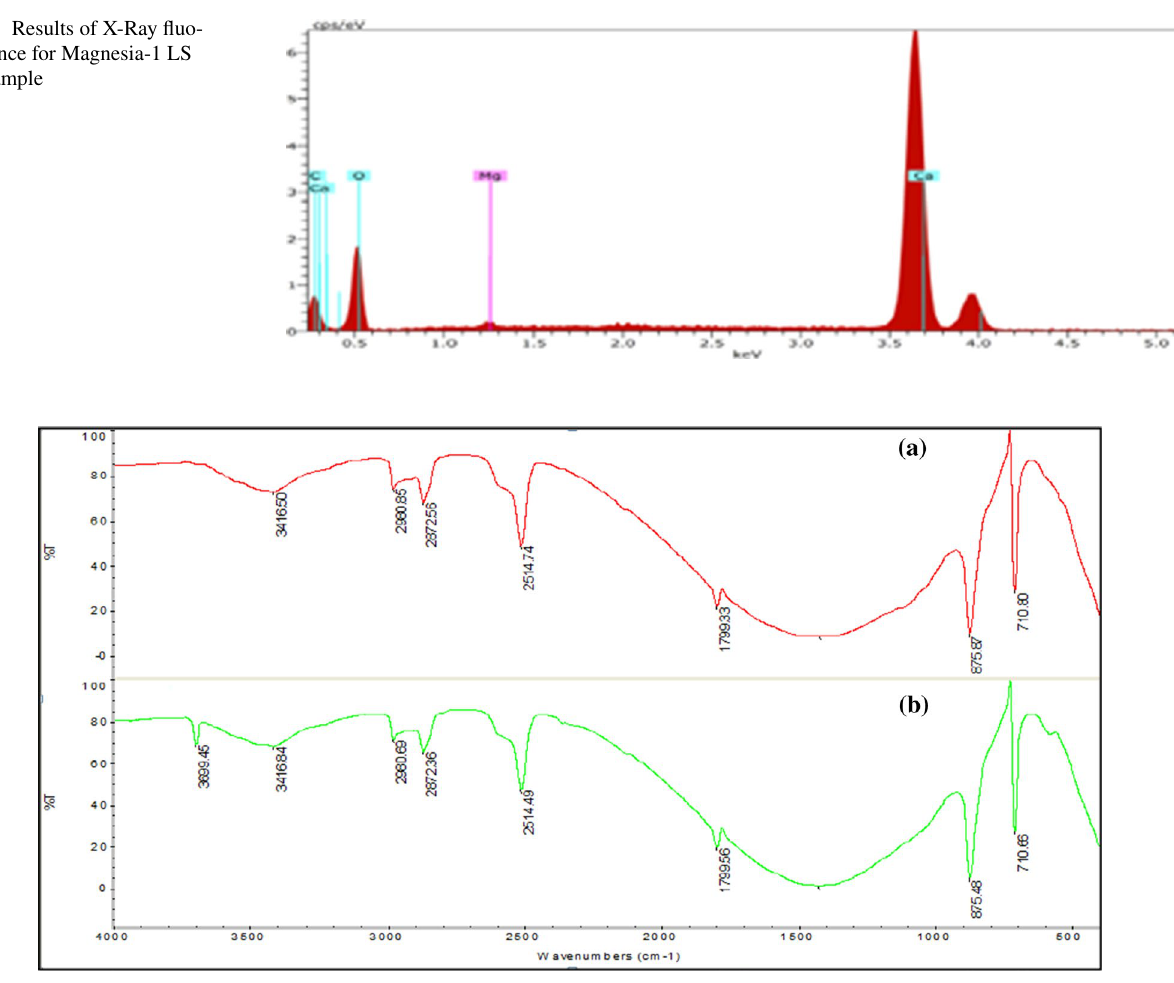
Fig. 2 Results of the FTIR analysis for a Magnesia, b Magnesia-1 LS Figure 3 spectrum of the native and amended LS follow- ing F − adsorption show that there were no major changes on native LS, while Magnesia-1 LS subsample shows that the particles surface functional groups significantly changed after the F − adsorption. This indicates a chemical process to had taken place as evidenced by significant band shifting and certain peak intensity due to the F − adsorption. Fur- thermore, additional peaks appeared in the high spectrum range 3200–3900 cm −1 . The appearance of these peaks may have indicated a formation of various oxides, and thus, may reflect the complexity and heterogeneity of the adsorbing surface sites (Focke et al. 2009; Markovic et al. 2009). A new peak of 564.17 cm −1 was gradually formed. This new peak can be assigned to the Mg–F stretching vibration, indi- cating the formation of MgF during the adsorption process 2 (Jin et al. 2016). The results of FTIR confirmed the presence peak was shifted to 1387 cm −1 . These peaks belonged to the surface carbonate groups of native LS. The former shift